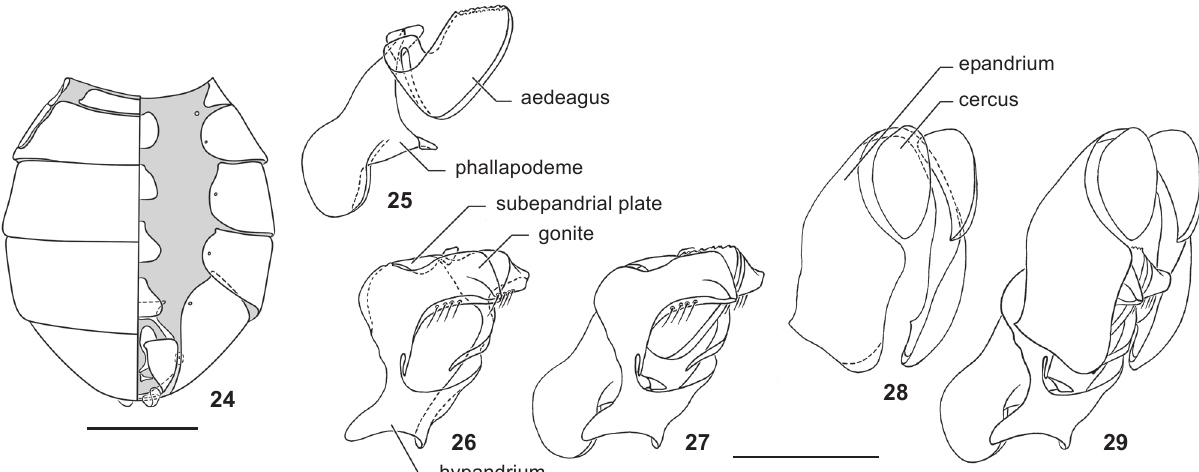
Figures 24-29. Parydra ochropus : (24) abdomen of male, dorsal and ventral views; (25) aedeagus and phallapodeme, latero-oblique view; (26) gonite, hypandrium, and subepandrial plate, latero-oblique view; (27) gonite, hypandrium, subepandrial, and phallapodeme, latero-oblique view; (28) epandrium and cercus, latero-oblique view; (29) male terminalia, latero-oblique view. Scale bars: 24 = 0.5 mm, 25-29 = 0.25